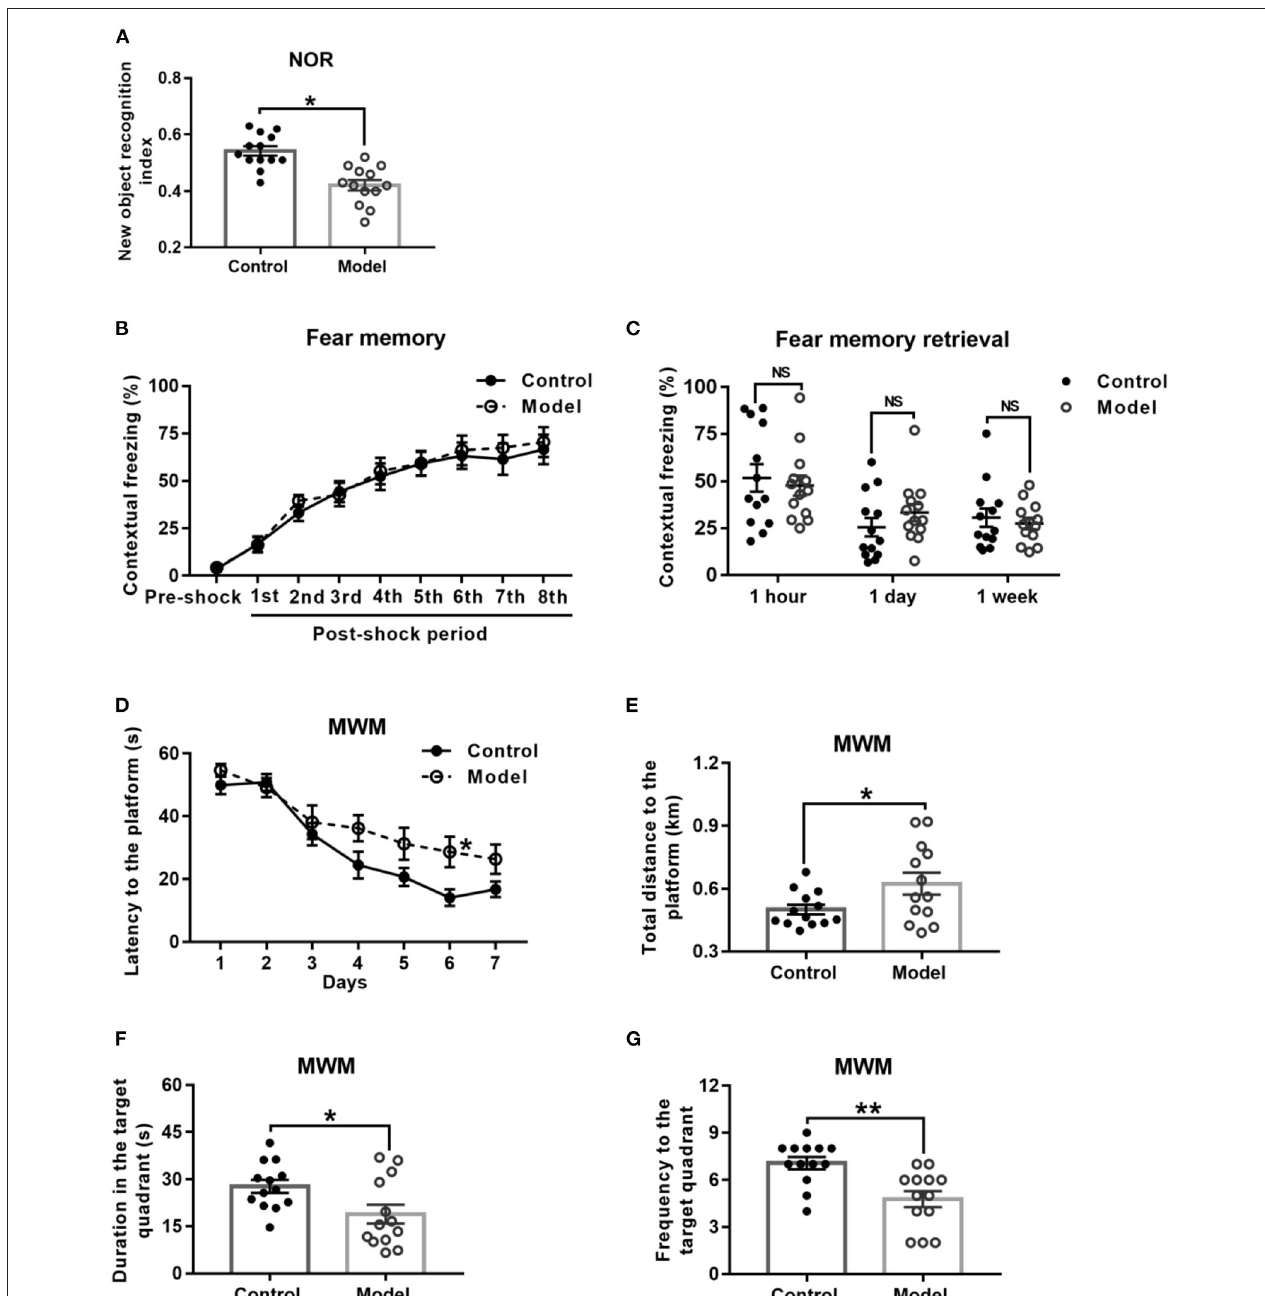
FIGURE 4 | Effect of bilaterally hippocampal injection of STZ on the behavior performance of mice in the NOR, CFC and MWM. The data are presented as the mean ± SEM, with 13 mice in each group. In the NOR, compared with control mice, the novel object recognition index of model mice (A) was remarkably reduced. There was no significant difference between the two groups in the stage of fear memory formation (B) and freezing time of mice when the fear memory was extracted after 1h, 1 day, and 1 week (C) in the CFC. In the MWM, during the acquisition phase, bilaterally hippocampal STZ-injected mice took longer time to find the submerged platform than the control mice did on 6th day (D) . During the probe trial, the model mice showed increased total swimming distance to the platform (E) , decreased duration (F) and less frequency (G) in the target quadrant. * P < 0.05, ** P < 0.01; compared with the control group, NS is no significance.